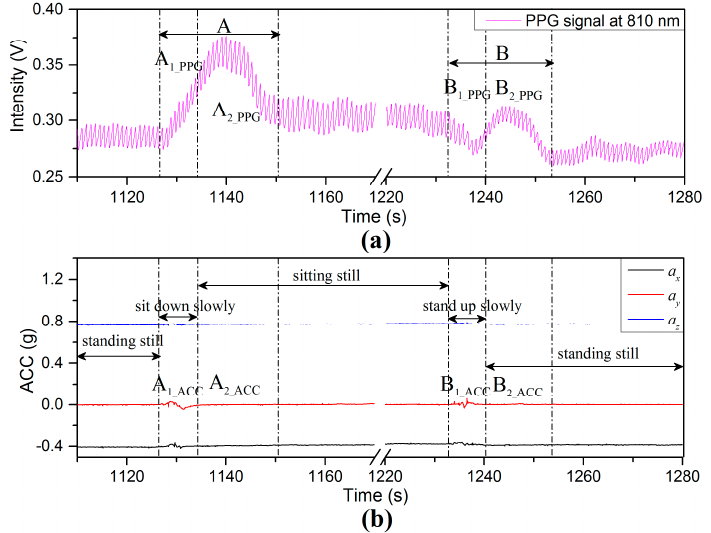
Figure 12. Enlarged portion of the PPG ( a ) and the ACC signals ( b ) in the interval 1110–1280 s in Figure 11.